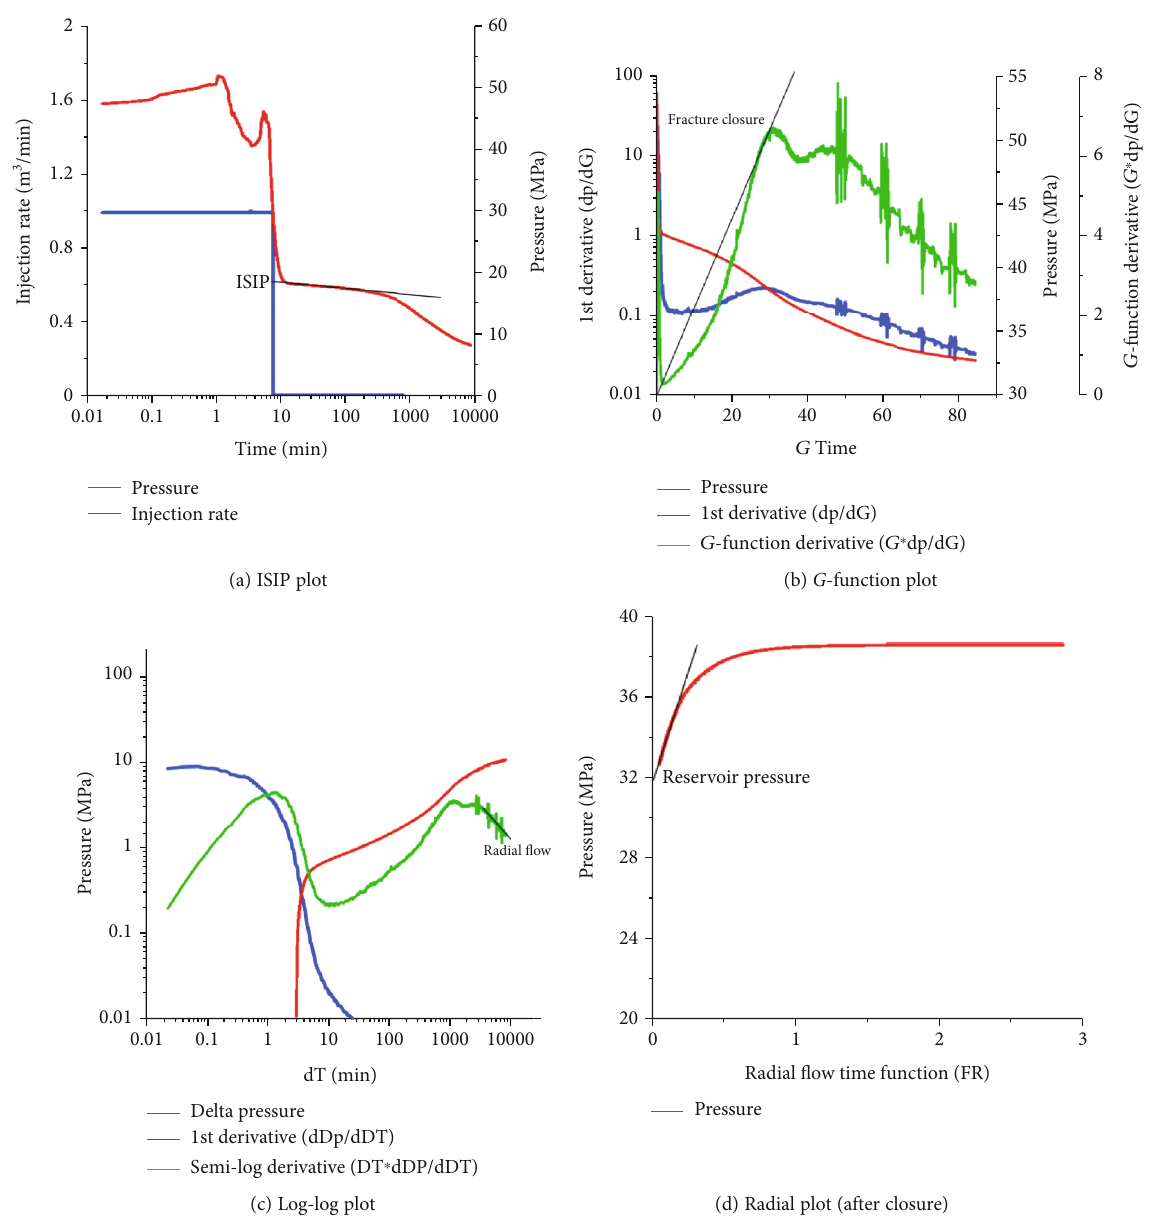
Figure 6: DFIT analysis